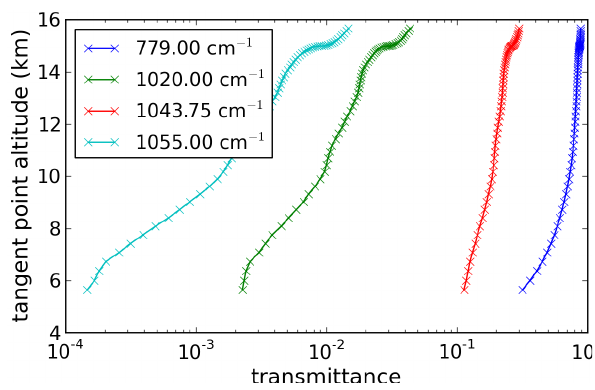
Fig. 9. The transmissivity of the four employed channels plotted at Fig. 7. The transmissivity of the four employed channels plotted at varying tangent altitudes. For mea- varying tangent altitudes. For measurements pointing upwards, the surements pointing upwards, the tangent altitude behind the measuring instrument has been mirrored at tangent altitude behind the measuring instrument has been mirrored at the instrument altitude at the instrument altitude at 15 km .